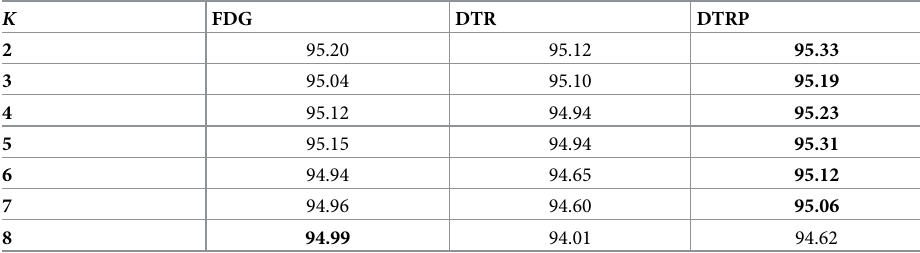
Table 3. Top-1 accuracy (%) of ResNet18 using different methods.